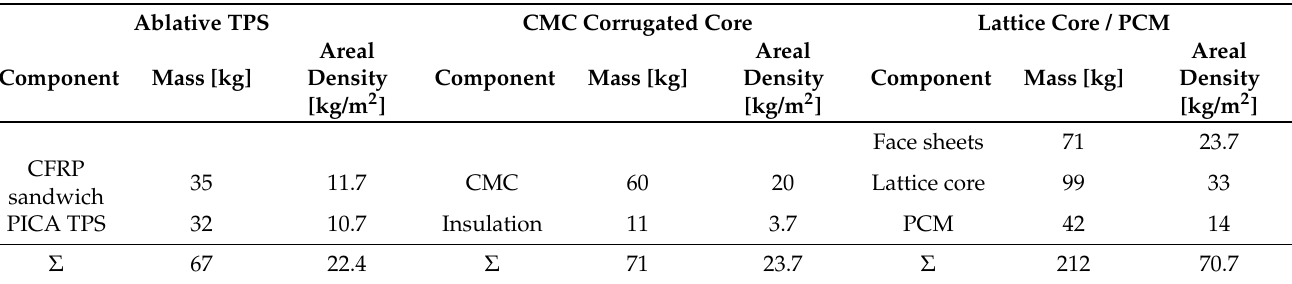
Table 6. Mass comparison of the three TPS